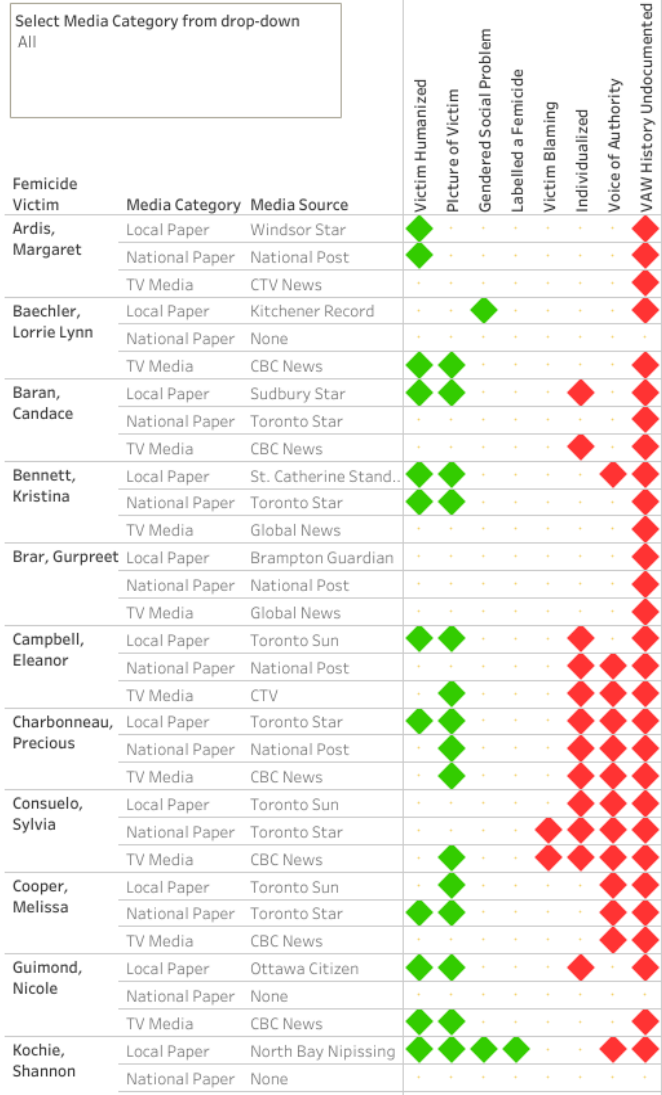
Figure 1. A sample screenshot from the knowledge mobilization (KMb) tool produced for the community partner. The “heat map” outlines positive and negative frames identified in different media reports for each of the 29 femicide victims in the years 2015–2016. A green or red diamond represents evidence of positive or negative framing respectively in that particular news report. On the full interactive version, available on the community partner’s website [See: https://www.oaith.ca/oaith-work/current-initiatives.html], users can select between local, national and TV media sources from the drop down menu found in the top left corner of the map. Additionally, clicking on the red or green diamond takes the user to the original media reports analyzed for this research product.